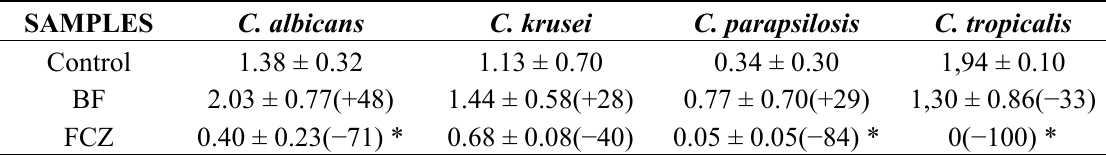
Table 2. Ergosterol quantification, in percentage